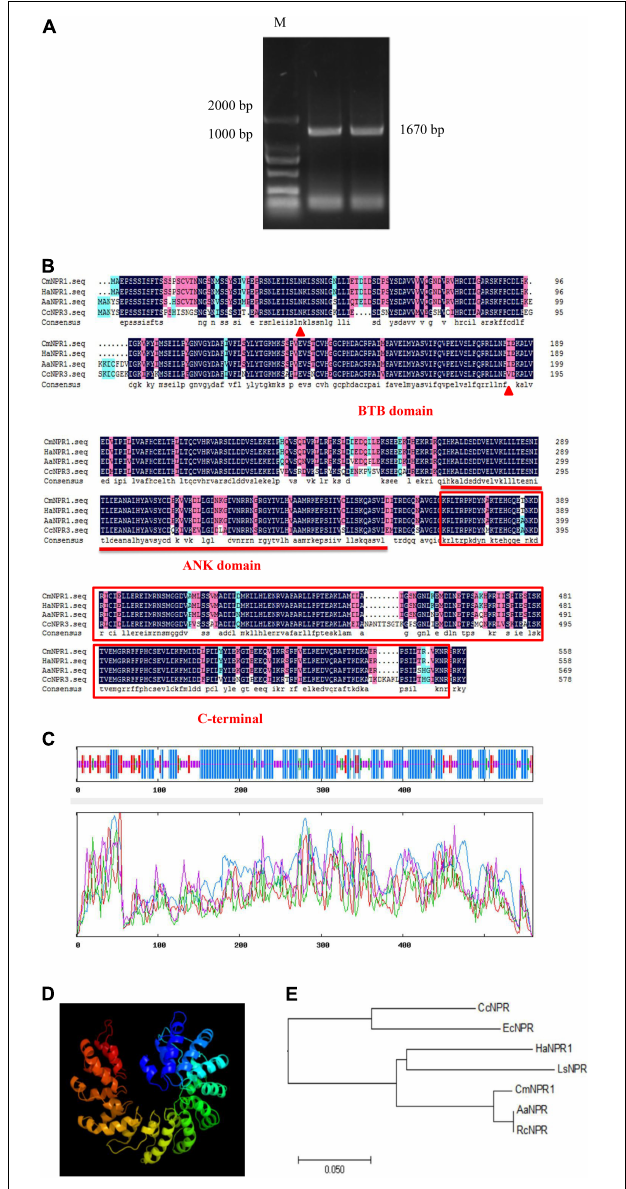
FIGURE 4 | (A) PCR amplification product of CmNPR1 : M, Marker. (B) Sequence alignment analysis between CmNPR1 and other several related NPR1 proteins from other Asteraceae. Triangle, N-terminal BTB/POZ domain; straight line, ANK domain; box, C-terminal NPR1/NIM1 region. Cm, Chrysanthemum morifolium ; Ha, Helianthus annuus L.; Aa, Artemisia annua ; Cc, Cynara cardunculus L. (C) The predicted secondary structure of CmNPR1. Blue, alpha helix; red, folding and extending chain; green, beta turn; yellow, random coil. (D) The predicted three-dimensional structure of CmNPR1. (E) Phylogenetic analysis of CmNPR1. Rc, Ricinus communis ; Ls, Lactuca sativa ; Ec, Erigeron canadensis .